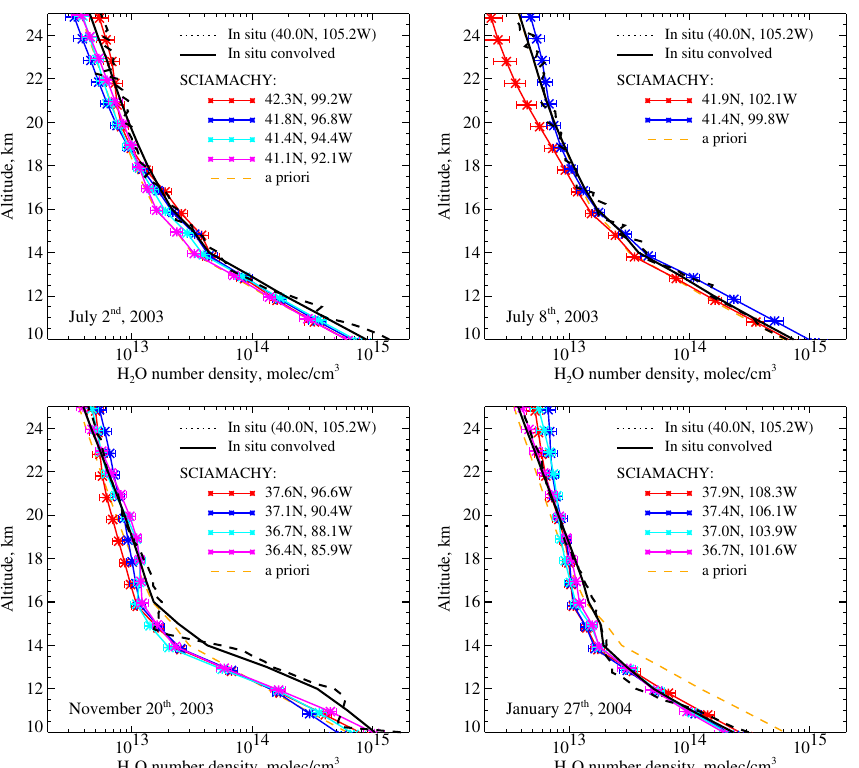
Fig. 17. Comparison to in situ measurements performed with a balloon-borne frost point hygrometer (FPH) over Boulder, CO, USA for four selected balloon launches. Original water vapor profiles obtained from the frost point hygrometer are shown with black dashed lines whereas black solid lines show the same profiles but convolved with SCIAMACHY averaging kernels. Color solid lines depict water vapor profiles retrieved from SCIAMACHY limb observations (up to four profiles per limb observation due to an azimuthal scan) and the dashed orange line shows the a priori water vapor profile used for SCIAMACHY